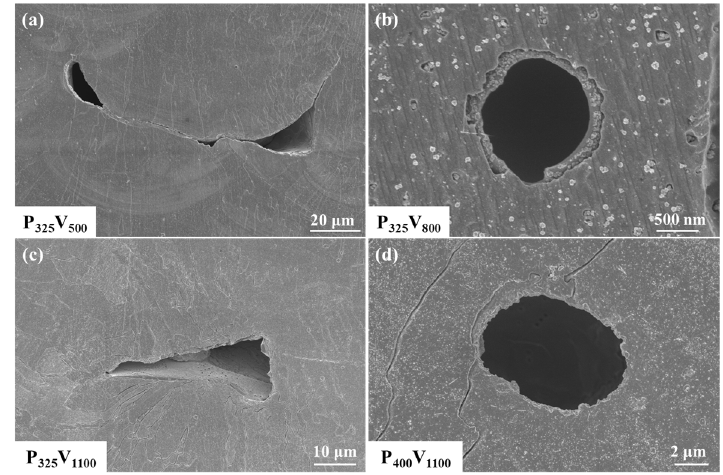
Figure 4. Defect morphology of Cu–Cr–Nb–Ti alloy prepared using di ff erent process parameters: ( a ) the irregular pore in sample P 325 V 500 , ( b ) the circular keyhole in sample P 325 V 800 , ( c ) the LOF pore in sample P 325 V 1100 , and ( d ) the keyhole in sample P 400 V 1100 .